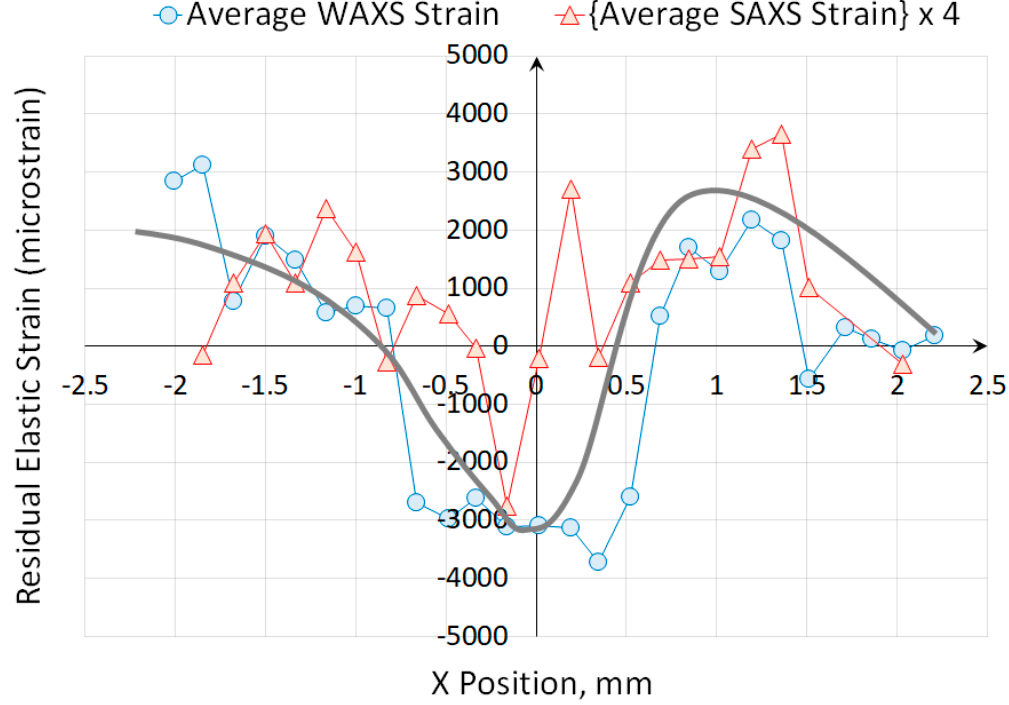
Figure 12. The comparison of strains obtained from the interpretation of WAXS and SAXS patterns. The continuous curve represents a guide to the eye.